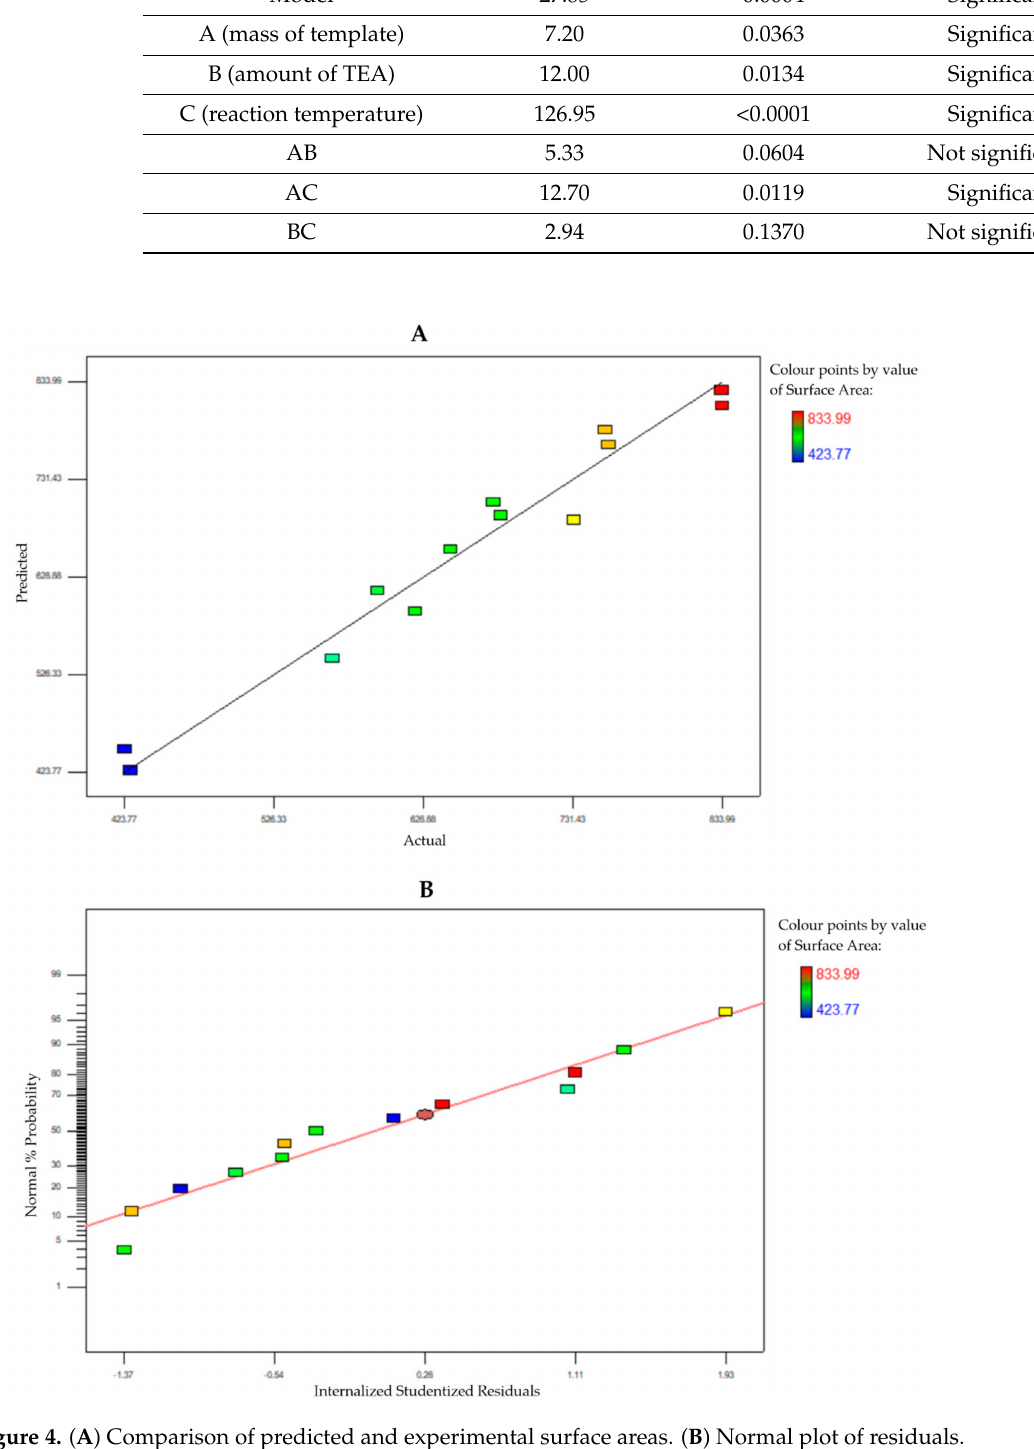
Figure 4. ( A ) Comparison of predicted and experimental surface areas. ( B ) Normal plot of